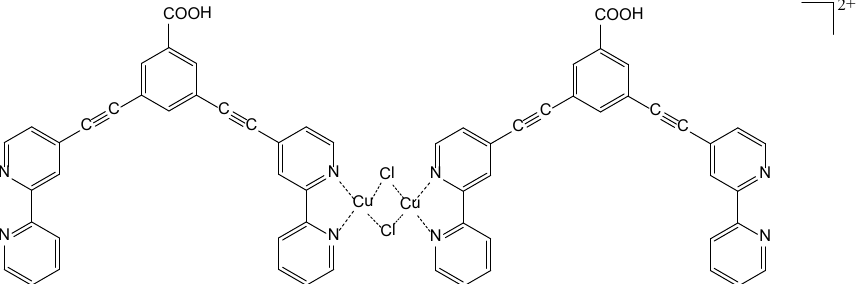
Figure 1. ESI mass spectra of solutions containing equal copper and ligand